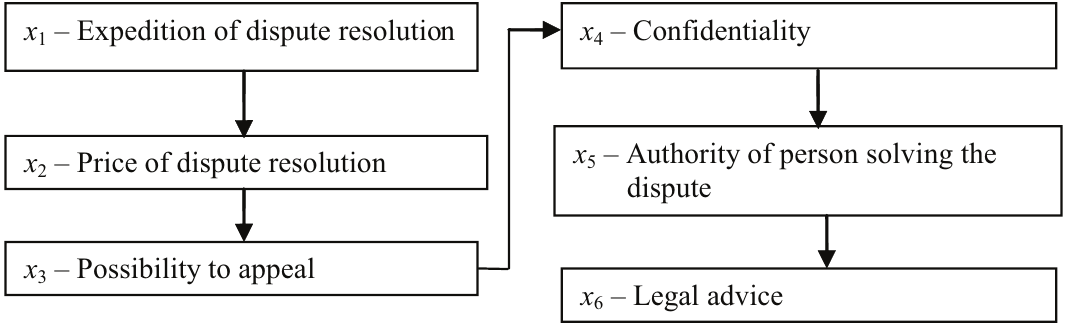
Fig. 3. Determination of attributes ranks